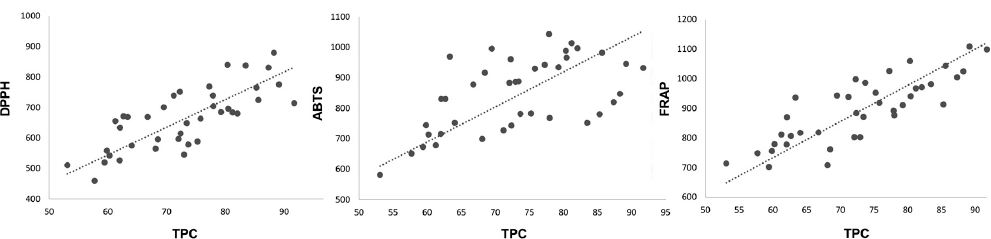
Figure 3. Correlations between radical scavenging capacity measured by DPPH, ABTS and FRAP methods (µmol Trolox 100 g − 1 FW) and TPC (mg GAE 100 g − 1 FW). methods ( µ mol Trolox 100 g − 1 FW) and TPC (mg GAE 100 g − 1